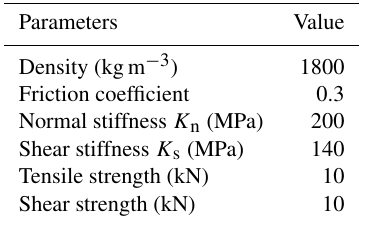
Table 1. Material parameters of numerical simulation.